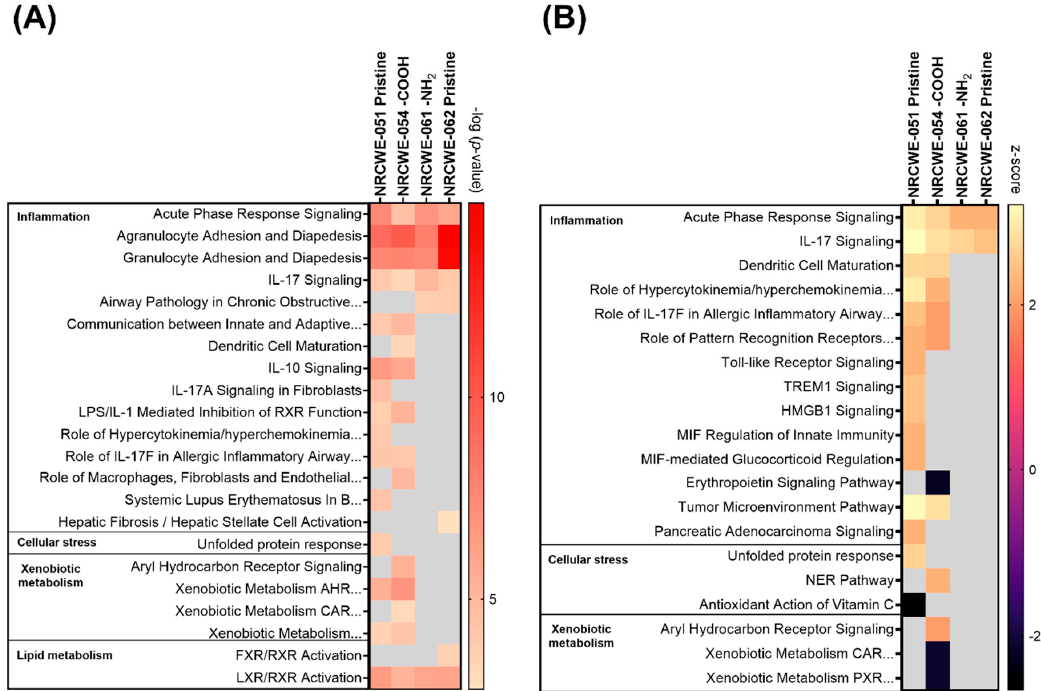
Figure 6. Top 15 perturbed canonical pathways after 1 day of exposure to CNTs at the 18 µ g/mouse dose. ( A ) The top 15 canonical pathways were considered significantly perturbed if − log ( p -value) was ≥ 1.3. ( B ) The top 15 canonical pathways were considered significantly activated if − log ( p -value) was ≥ 1.3 with a z-score ≥ 2 or significantly inhibited if − log ( p -value) was ≥ 1.3 with a z-score ≤ − 2. Gray represents canonical pathways that were not significant, were not part of the top 15 most significantly perturbed pathways ( A ), or were not significant pathways with highest |z-score| ( B ). Pathways related to inflammation, lipid and xenobiotic metabolism were regulated with respect to the MWCNTs, but agranulocyte/granulocyte adhesion and diapedesis